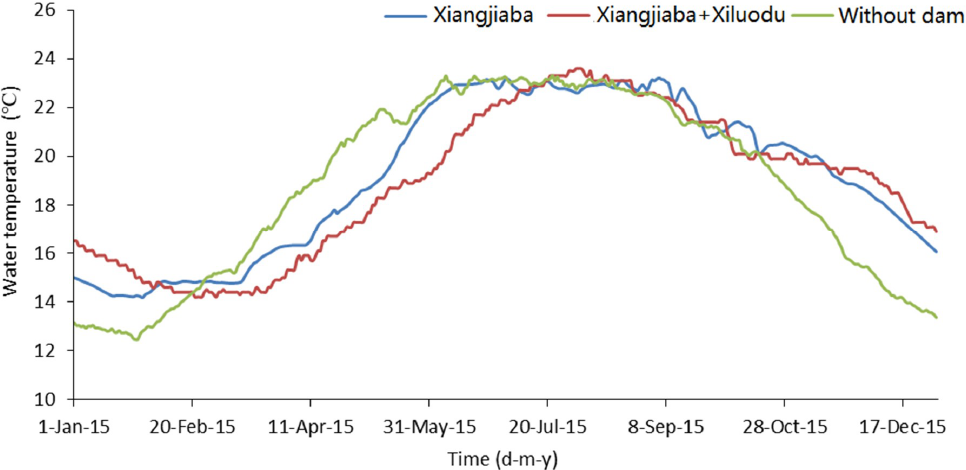
Figure 8. Water temperature of the discharge at the Xiangjiaba reservoir in 2015 for different situations (without dam: average water temperature from 2000 to 2011, Xiangjiaba: the Xiangjiaba dam with river water temperature inflow; Xiangjiaba + Xiluodu: both dams in operation).